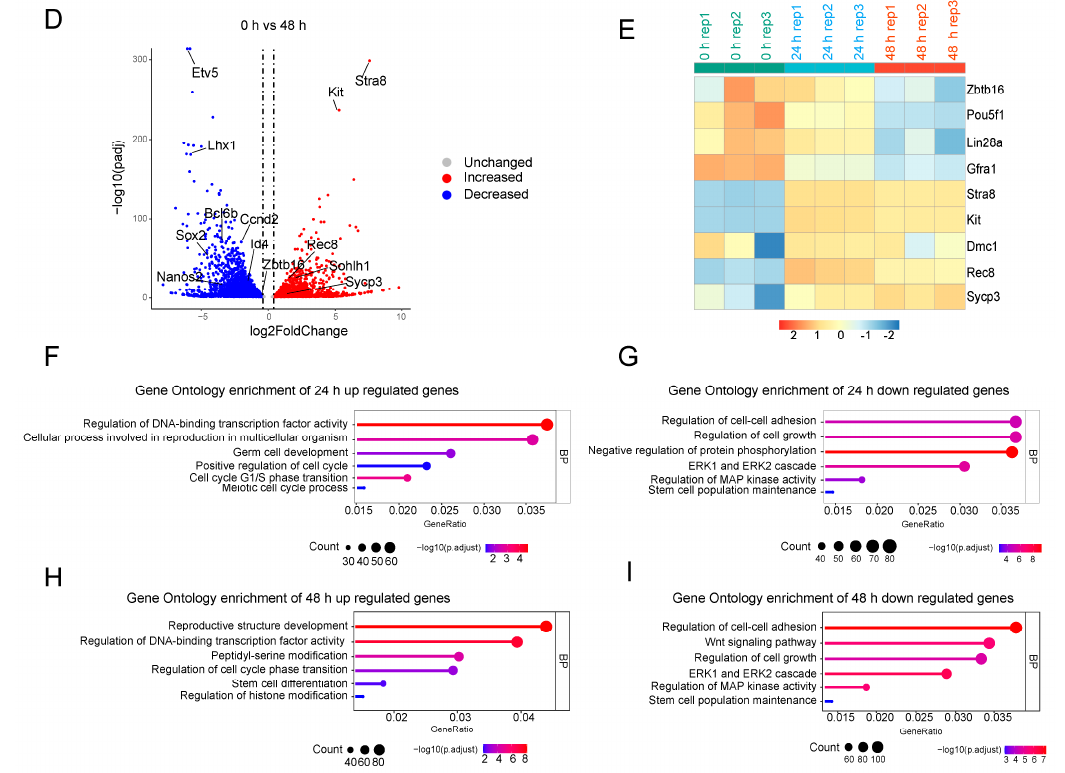
Figure 2. RNA-seq analysis of SSCs differentiation in vitro. ( A ) Flow sorting of differentiated spermatogonial cells and GFP-negative mouse embryonic fibroblast cells were used as control. ( B ) Comparison of RNA-seq data at three stages of differentiation in vitro with a reported in vivo single-cell RNA-seq data, the curve represents the differentiation trajectory. Q-ProSPG represents quiescent prospermatogonia, T-ProSPG represents transitional prospermatogonia, Undiff.ed SPG represents undifferentiated spermatogonia, Diff.ing SPG represents differentiating spermatogonia, Diff.ed SPG represents differentiated spermatogonia. ( C ) Volcano plot revealed genes that were up or down-regulated at 24 h of differentiation, with gene expression at 0 h as a control. (Foldchange ≤ 1.3 or >1.3, adjusted p valve < 0.05). ( D ) Volcano plot revealed differentially expressed genes at 48 h of differentiation, with gene expression at 0 h as a control. (Foldchange ≤ 1.3 or >1.3, adjusted p valve <